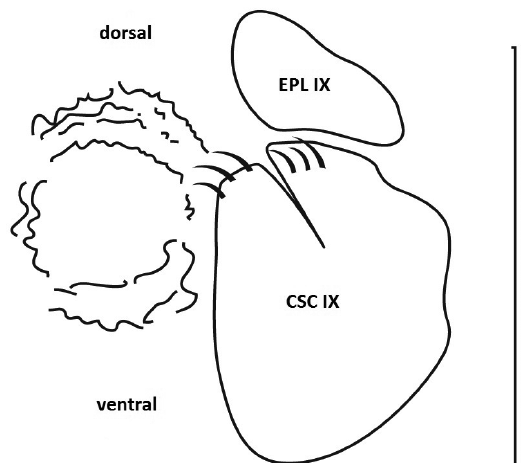
Figure 2. Atrichelaphinis ( Eugeaphinis ) deplanata (Moser, 1907). Female genitalia (EPL IX: epipleurite IX; CSC IX: coxosubcoxite IX) (Scale bar = 1